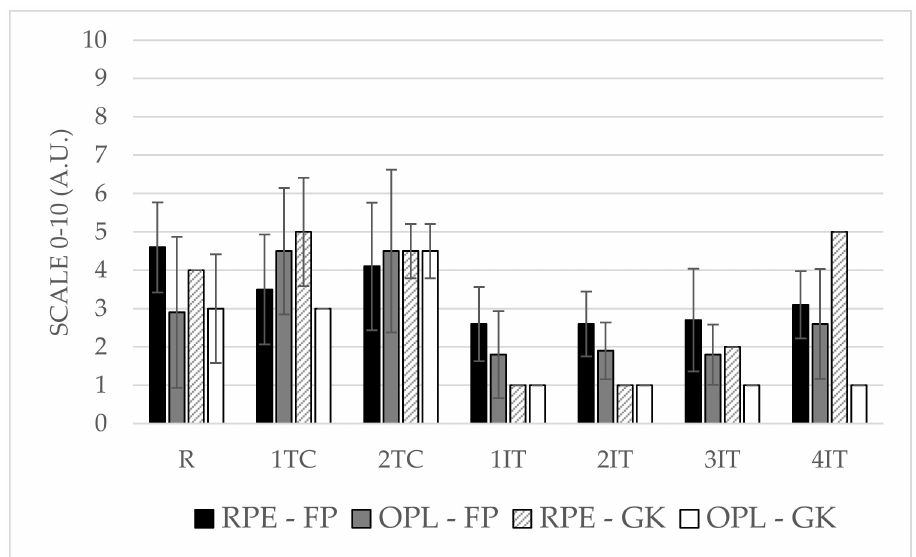
Figure 4. The rate of perceived exertion of field players (RPE—FP) and goalkeepers (RPE—GK) and overall pain level of field players (OPL—FP) and goalkeepers (OPL—GK) during subsequent days of training camp (1TC-1st day and 2TC-2nd day of training camp) and subsequent matches on international tournament (1–4 IT for 1st,2nd,3rd and 4th match, respectively) in Amputee Football compared with RPE and OPL assessed as a recall of typical feelings after match (R).